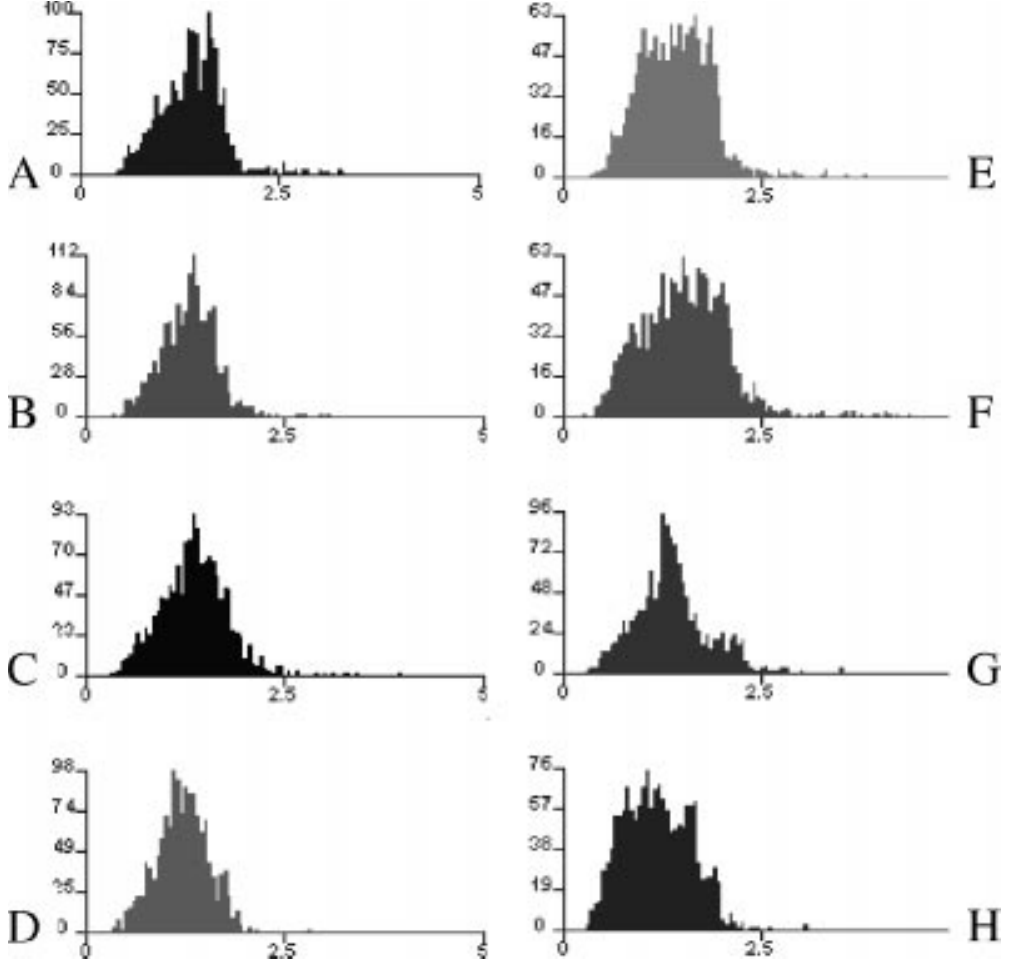
Fig. 4. IOD histograms of all measured nuclei per subgroup. (A) and (B): training set of normal epithelium (A), and of benign epithelium with inflammatory stroma infiltrate (B), (C) and (D): training set of normal-appearing epithelium with low-density (C) and high-density (D) inflam- matory infiltrate of the stroma nearby invasive cancer, (E) and (F): test set of normal epithelium (E) and of benign epithelium with inflammatory infiltrate (F), (G) and (H): benign- appearing epithelium nearby invasive cancer with low-density (G) and high-density (H) inflammatory stroma